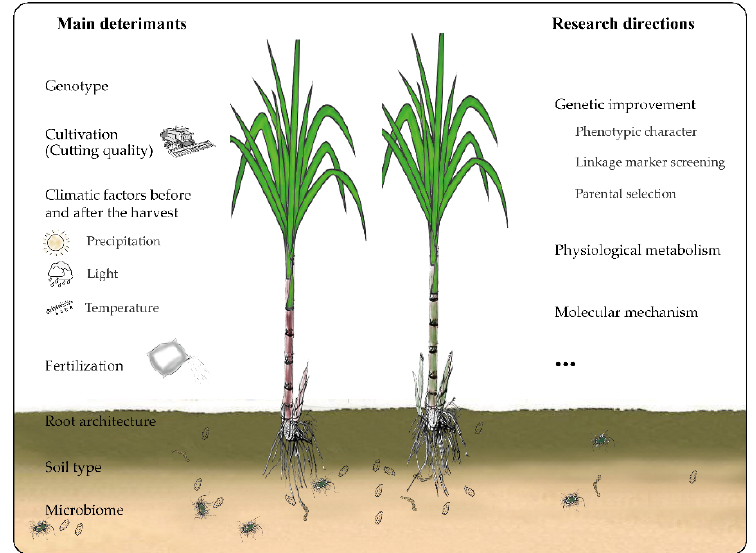
Figure 1. The main determinants and research directions for sugarcane rationing. Markers associated with target traits are valuable for breeding. In sugarcane, markers associated with sugarcane traits, including sucrose content and sugar content, have previously been studied [73–76]. In addition, markers associated with sugarcane yellow spot resistance have also been studied [77]. However, thus far, only markers associated with the major gene, Bru1 , which is responsible for sugarcane brown rust resistance, have been used in breeding. The first marker to be identified was 10 cM from the Bru1 gene [78]. Furthermore, markers that were 1.9 cM and 2.2 cM from the gene were observed [79], but only the markers that were 0.28 cM and 0.14 cM from the Bru1 gene were identified [80] and used to assist the selection in breeding [81–83]. Nevertheless, these markers still have the problem of false positive [81], that is, the markers can be detected in a line without the actual disease resistance. It is difficult to identify markers closely associated with target traits because a complete reference genome is still unavailable for sugarcane; however, some progress has been made [84–87]. Therefore, adding the full-length transcriptome unigene data of the hybrid parents as a supplement to the reference genome sequence, and using these data in genes. What should also be stressed here is that mining key regulatory genes associated with excellent traits, clarifying the allelic variation of these key genes, and analyzing the distribution and genetic effect of haplotypes, are all important for elucidating sugarcane ratooning ability and for gene editing breeding